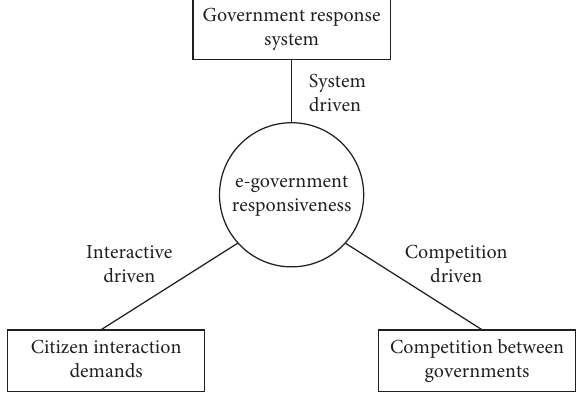
Figure 1: Framework of SCI analysis